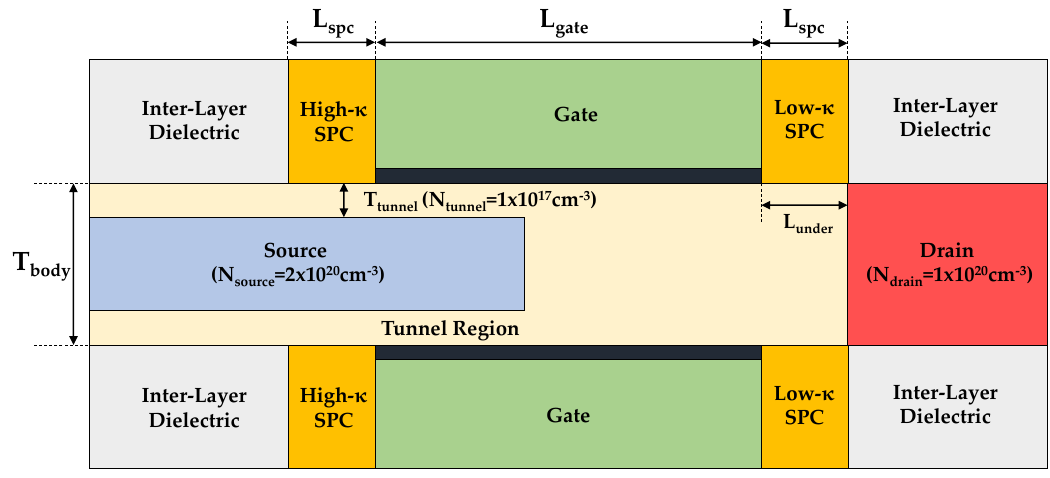
Figure 1. The schematic of the proposed tunnel field-effect transistor (FET), which have double gate, asymmetric spacers, and a tunnel channel region to improve the tunneling current.